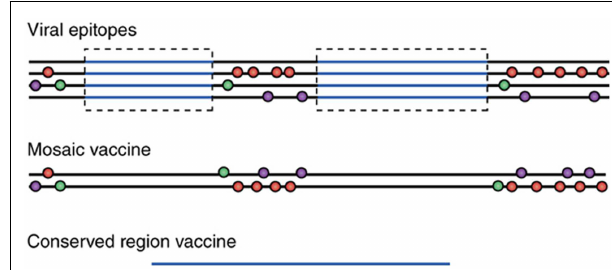
FIGURE 2 |Vaccines that deal with HIV-1 variability . Construction of vaccines based on viral sequences in four viral isolates (top; simplified representation): horizontal lines indicate viral sequences; circles indicate sites of greatest variability between isolates (and potential escape mutations from CTL pressure; there may be more than two alternative sequences at each spot); and blue lines indicate regions of relative conservation (although in reality no region of HIV-1 is invariant).The mosaic vaccine (middle) is constructed to include the most common variants from the isolates in as few strands as possible while conserving naturally occurring sequence stretches. In the conserved region-containing vaccine (bottom), the relatively conserved regions (blue) are excised and then are “stitched” together (which creates an unnatural junctional region).The regions typically vary from 30 to 120 amino acids in length. Reproduced with permission from Ref. (63).